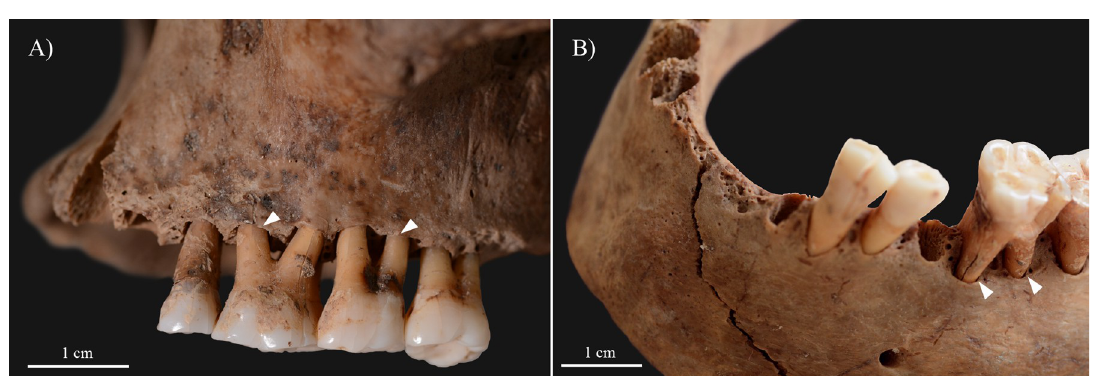
Fig 5. Alveolar bone recession (white arrows) of the A) maxillary and B) mandibular teeth of KK61, with ante-mortem loss of the mandibular central incisors.